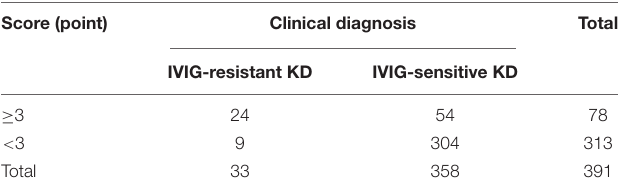
TABLE 5 | Validation of the scoring